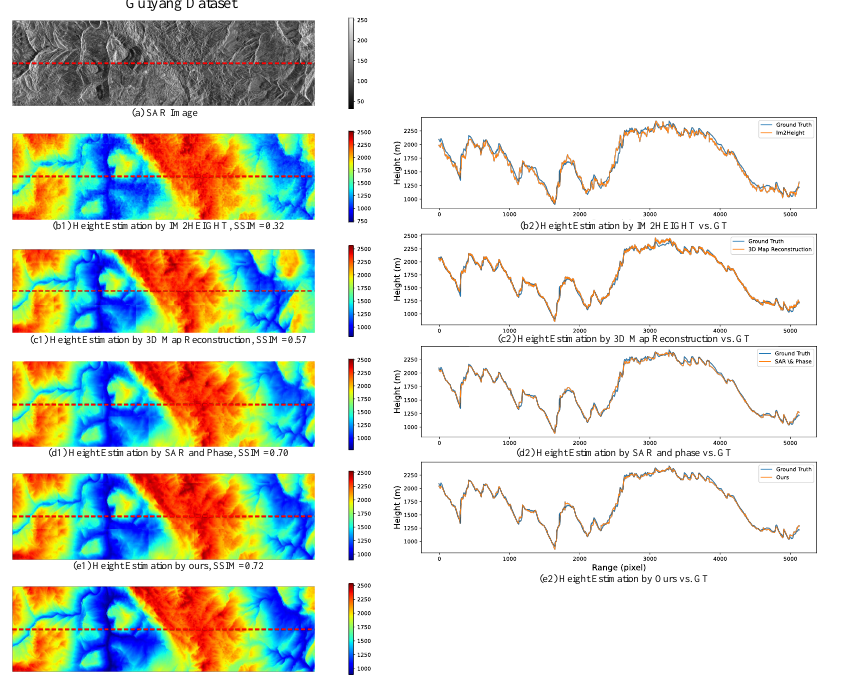
Figure 8. Height estimation result of different methods in Guiyang datasets. From top to bottom, ( a ) is SAR image. ( b1 – e1 ) are the estimated height by IM2HEIGHT, 3D map reconstruction, SAR&phase and ours, respectively. Elevation lines along range directions with a fixed middle azimuth value marked by red dash lines in ( b1 – e1 ) are plotted in ( b2 – e2 ) respectively. ( f ) is the ground truth height map. The downsampling factors of SH are 96 × 96.